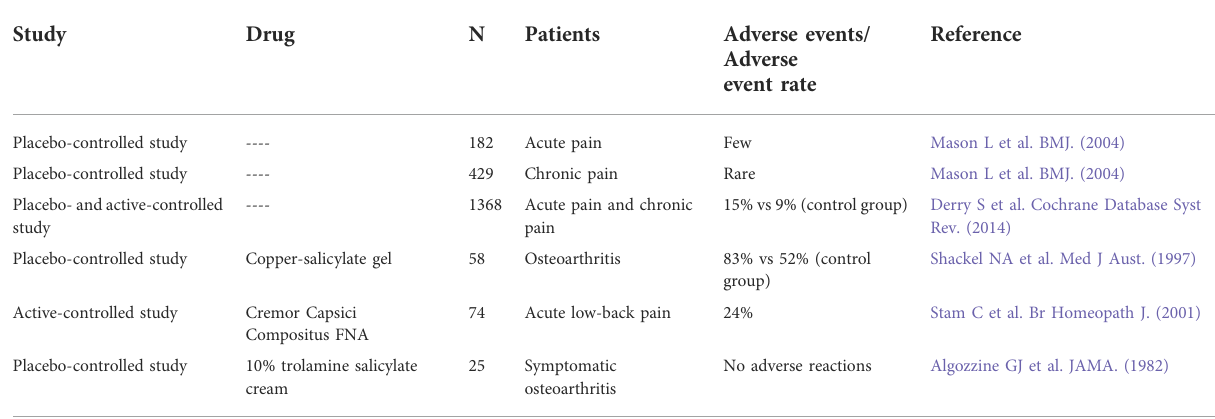
TABLE 7 Adverse events of salicylates reported in different